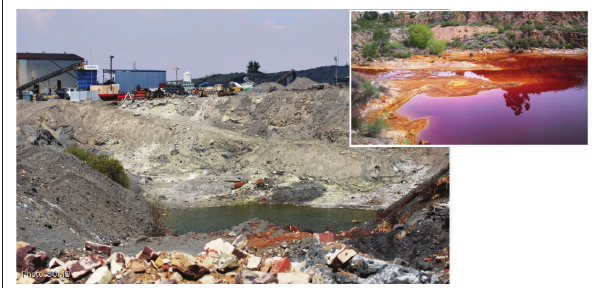
FIGURE 3: Mintails South Africa: Tailings storage facilities